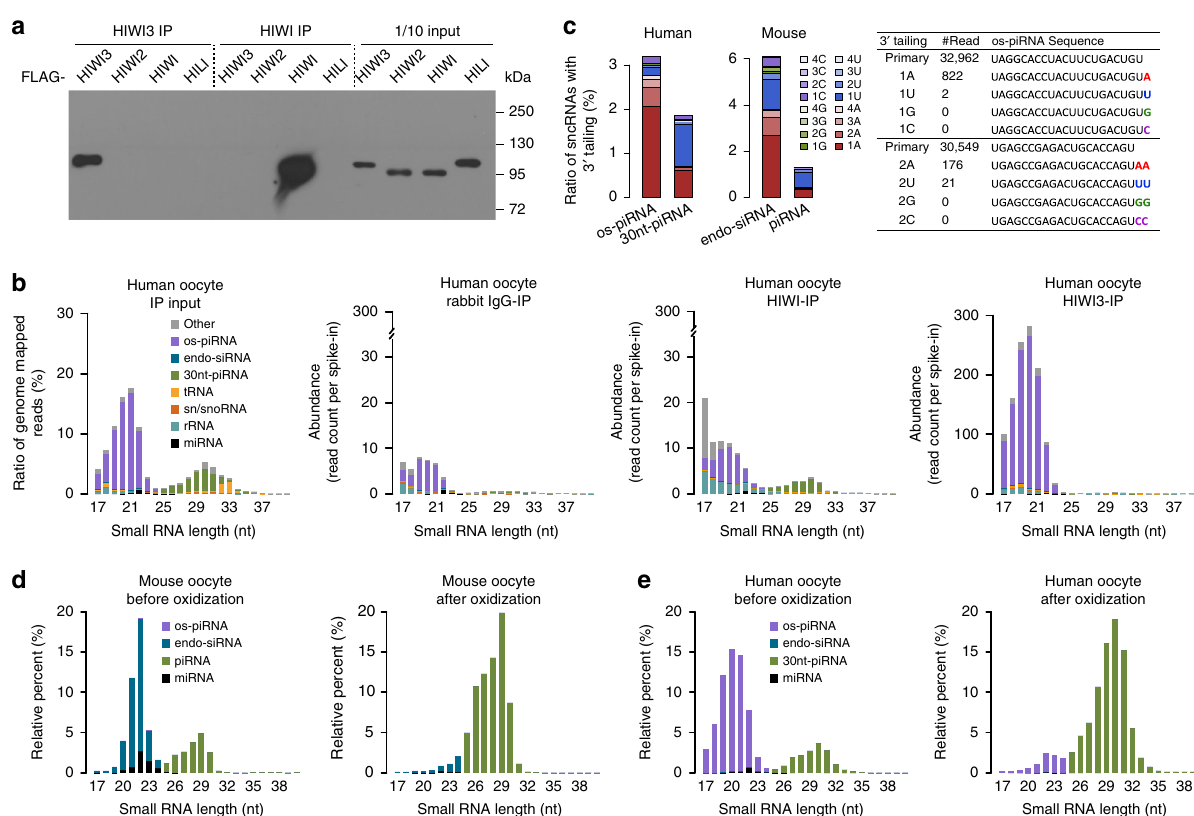
Fig. 3 The interacting protein and 3 ′ modi fi cation of oocyte short-PIWI-interacting RNAs (os-piRNAs). a Speci fi city of anti-HIWI and anti-HIWI3 antibodies. FLAG-tagged HIWI3, HIWI2, HIWI, and HILI were ectopically expressed in HEK293 cells. The cell lysates were immunoprecipitated with HIWI3- or HIWI-speci fi c antibodies and immunoblotted with an anti-FLAG antibody. b os-piRNAs were enriched by HIWI3 immunoprecipitation (IP) in human oocytes. The abundance and length distribution of small RNAs in the input and immunoprecipitated (IP) samples of oocytes are shown. Three or four human oocytes were used for each IP reaction. Rabbit nonspeci fi c immunoglobulin G (IgG) antibody served as a negative control. The abundance of small RNAs was normalized to an exogenous spike-in. c The ratio of small RNAs tailed with mono- and oligo-nucleotides in human and mouse oocytes is shown. The instances of 3 ′ adenylation in os-piRNAs are shown. d , e Composition of small RNAs in the mouse and human oocytes before and after NaIO 4 oxidization. The average result of three biological replicates is shown. Source data of a – e are provided in the Source Data fi